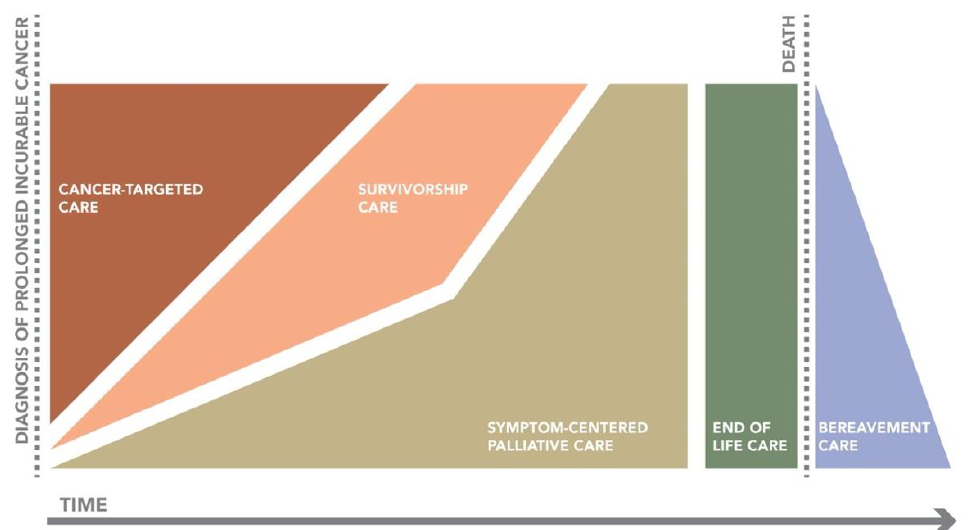
Figure 1. Proposed care model for patients with prolonged incurable cancer. Model adapted from original model by Lynn & Adamson [40]. Within this model, cancer-targeted care focuses on treatment of the tumor and/or metastases. Survivorship care is characterized by surveillance (for disease flare-ups), management of long-term physical and/or psychosocial symptoms, late treatment effects and general healthcare. Symptom-centered palliative care addresses acute or other physical and/or psychological symptoms as well as problems that may arise from the social or existential domain.